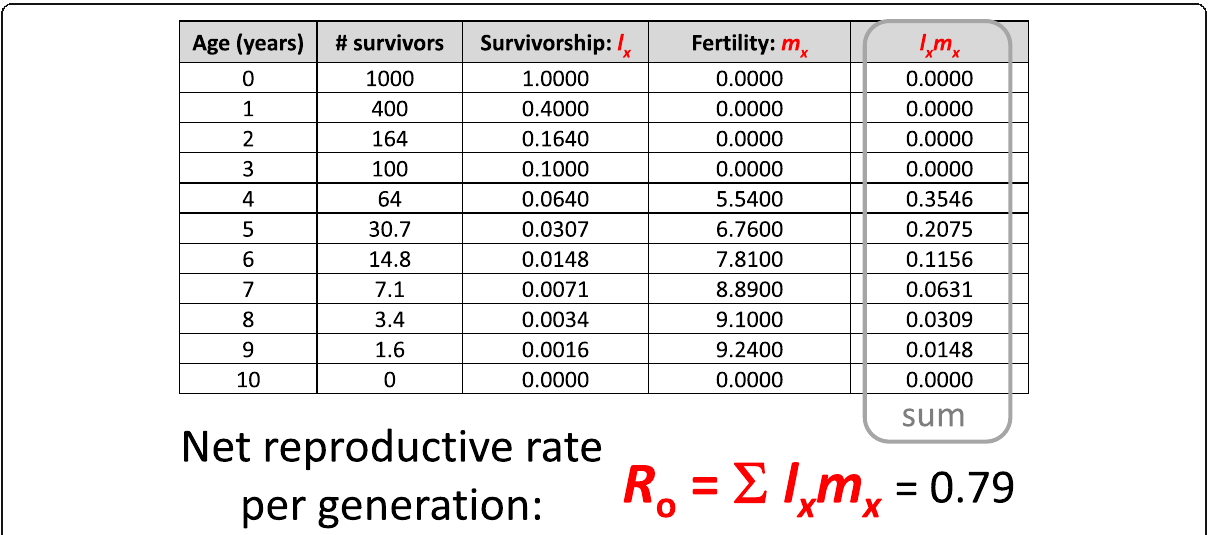
Fig. 1 Slide presented during Amanda ’ s instruction. The data table of the snake population and the equation for calculating R 0 on a slide presented during